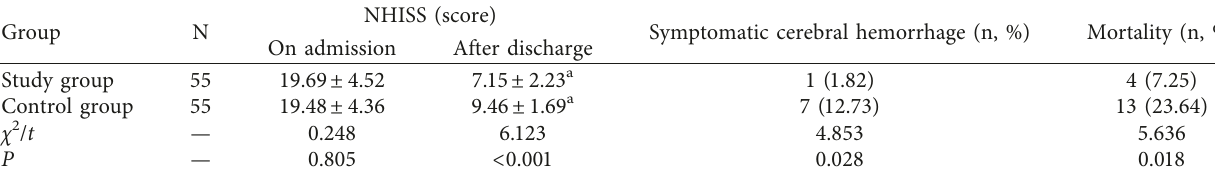
Table 4: Comparison of clinical outcomes between the two groups.